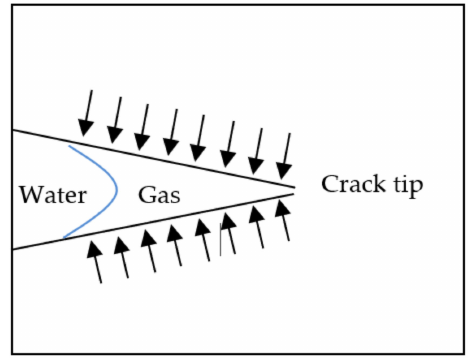
Figure 8. Meniscus effect of